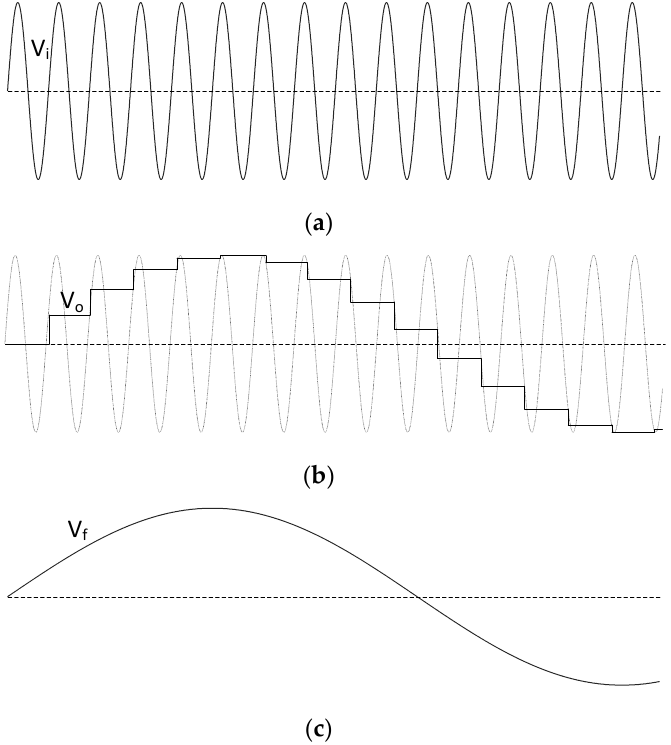
Figure 6. Illustration of the operation principle of the SH circuit in Figure 5 in the time domain. A sinusoidal signal is subsampled with a sampling frequency slightly lower than the sinewave fundamental frequency. The three voltages indicated in Figure 5 are plotted: ( a ) analog input of the SH, V i ; ( b ) analog SH output V o with frequency downscaling; and ( c ) filtered output signal V f .